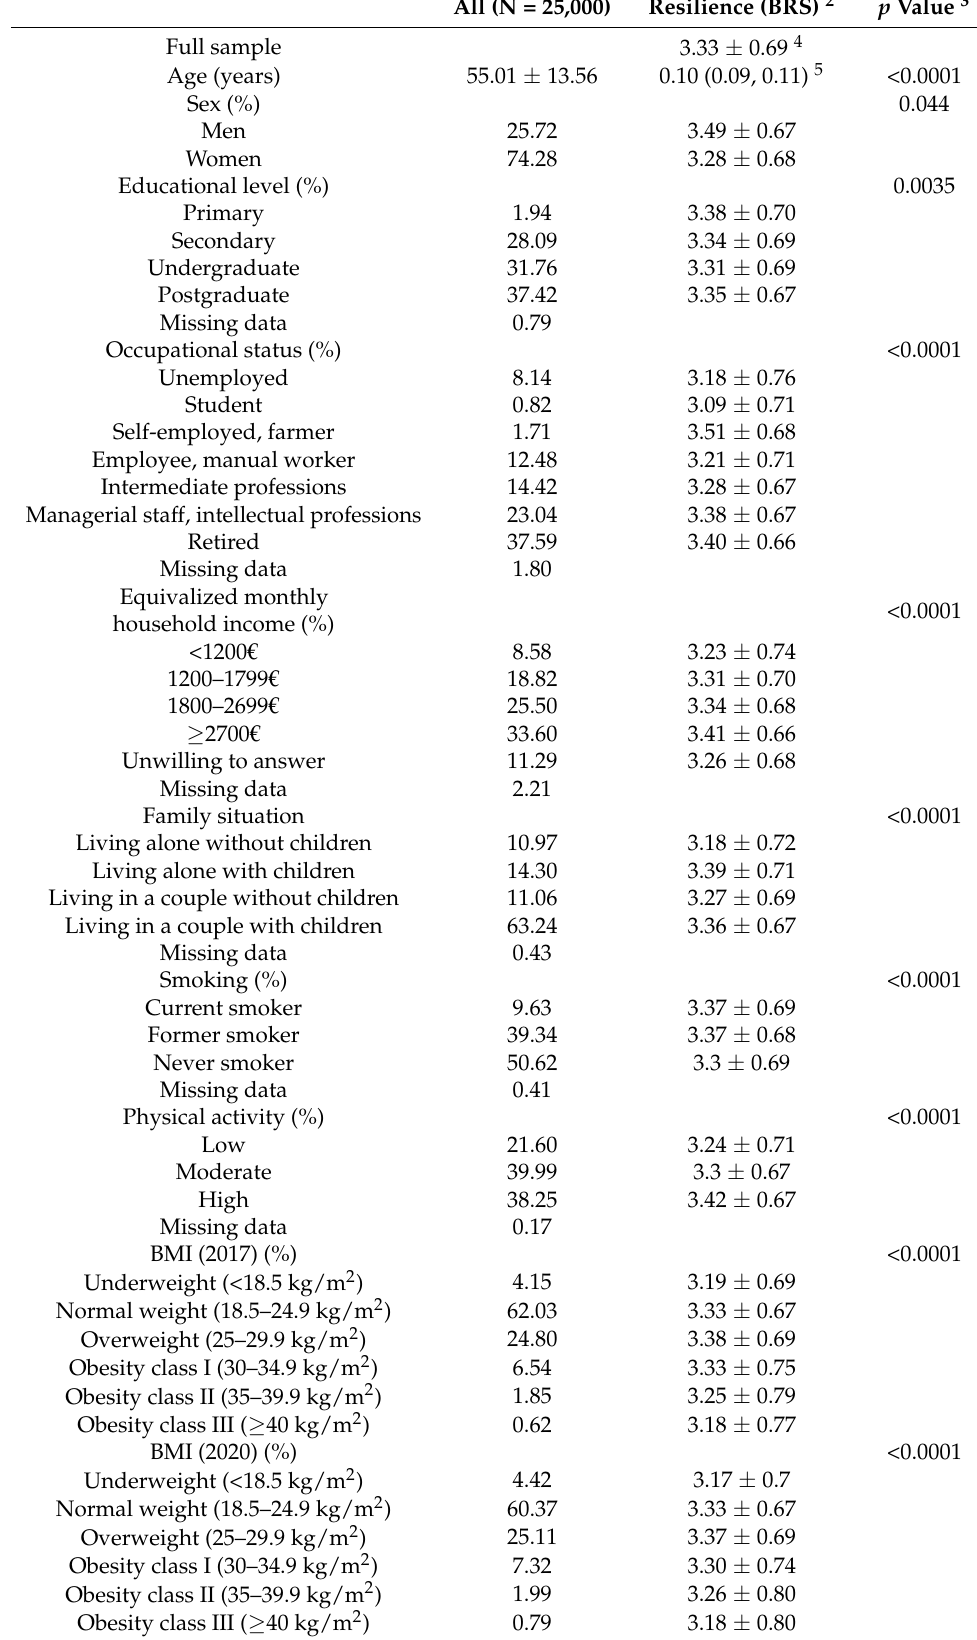
Table 1. Descriptive characteristics of the participants and the respective resilience (BRS) scores 1